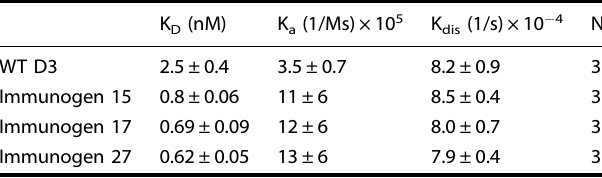
Table 1. The neutralizing mAb TB31F binds lead immunogens 15, 17, and 27 stronger than WT D3.